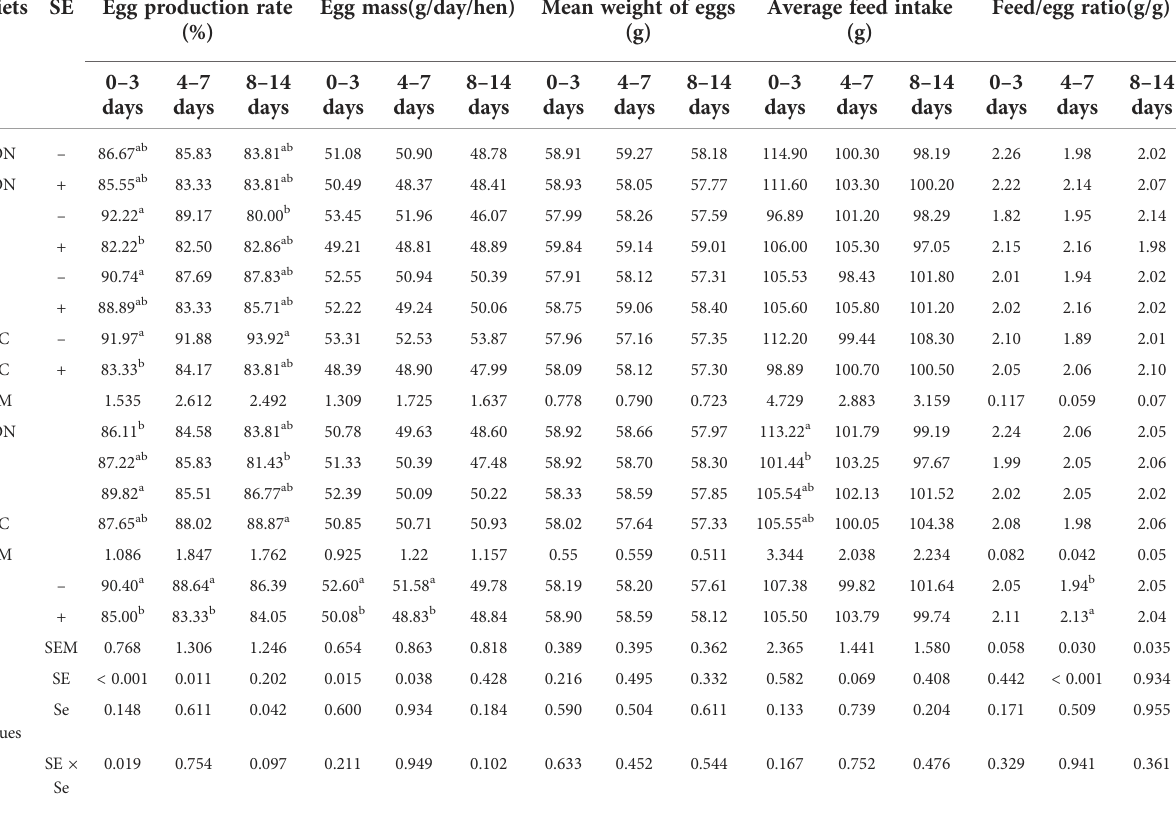
Different letters indicate statistically signi fi cant differences among different treatments (P < 0.05). CON, basal diet; IS, sodium selenite; YS, yeast selenium; SYC, selenium-enriched yeast culture; SE, Salmonella Enteritidis; – , with physiological saline solution challenge; +, with SE